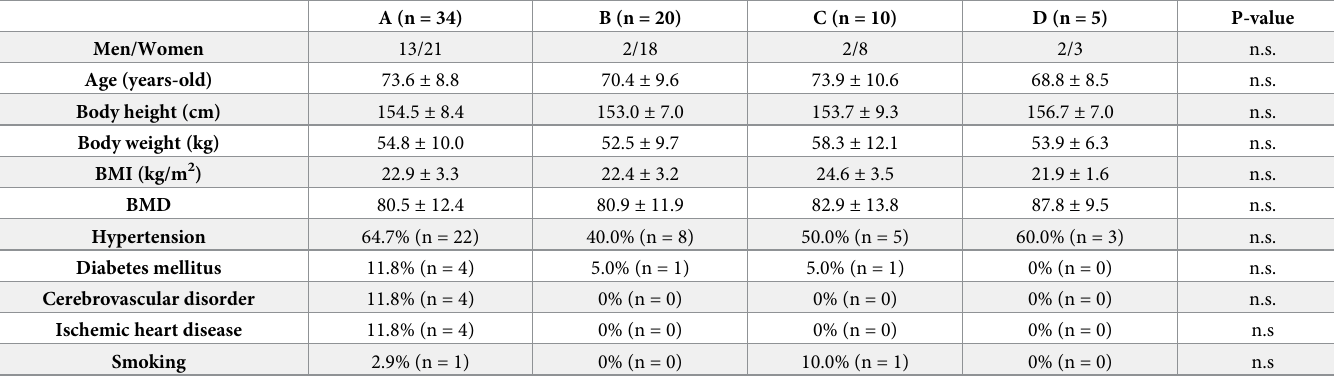
Table 3. Characteristics of subjects who had LBP in one location (LBP-one location group).